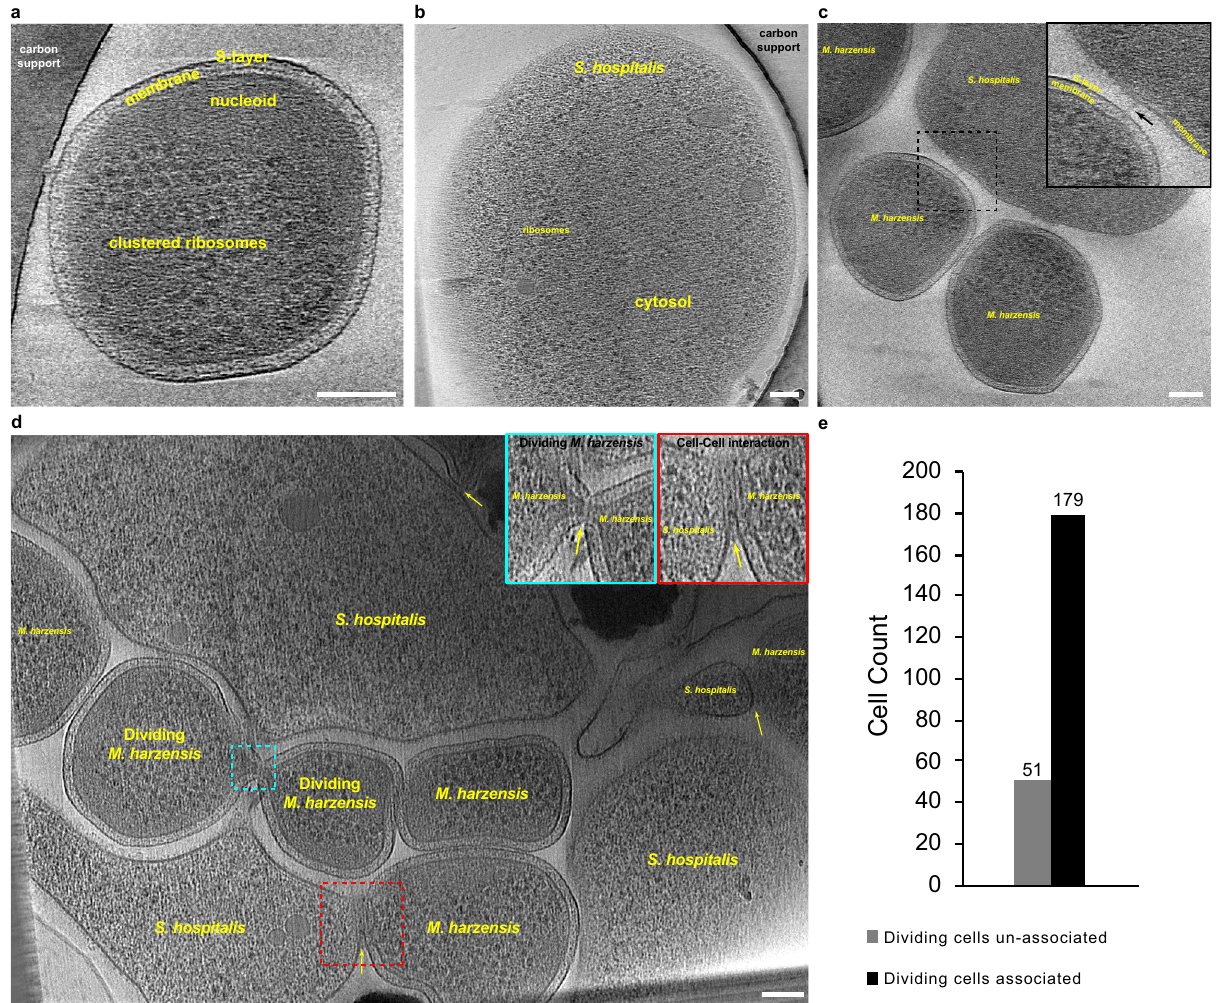
Fig. 8 Cryo-ET study of a Ca . Micrarchaeum harzensis- Ca . Schef fl eriplasma hospitalis co-culture. Shown are ( a ) a tomographic slice through a Ca . Micrarchaeum harzensis cell, ( b ) a tomographic slice through a Ca . Schef fl eriplasma hospitalis cell, ( c ) attachment sites and ( d ) cell surface remodelling of both organisms, as well as ( e ) results of a quanti fi cation of associated and un-associated dividing Ca . Micrarchaeum harzensis cells. Arrows highlight a fi lamentous structure (panel c ) and attachment sites undergoing surface remodelling (panel d ). Scale bars equal 100 nm. Additional Tomograms displaying Ca (Supplementary Movies 1 – 3). The experiment was performed two times with equivalent